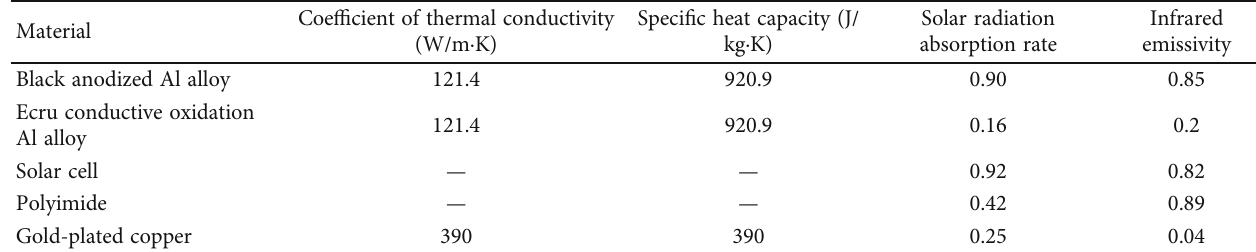
Table 2: The reference material parameters in the simulation.